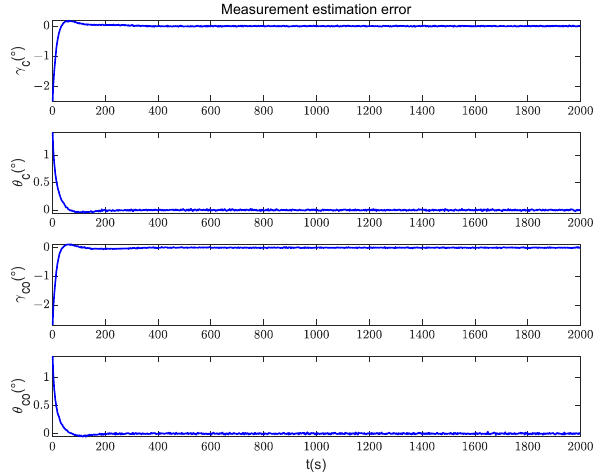
Figure 15. Measurements’ estimation errors.